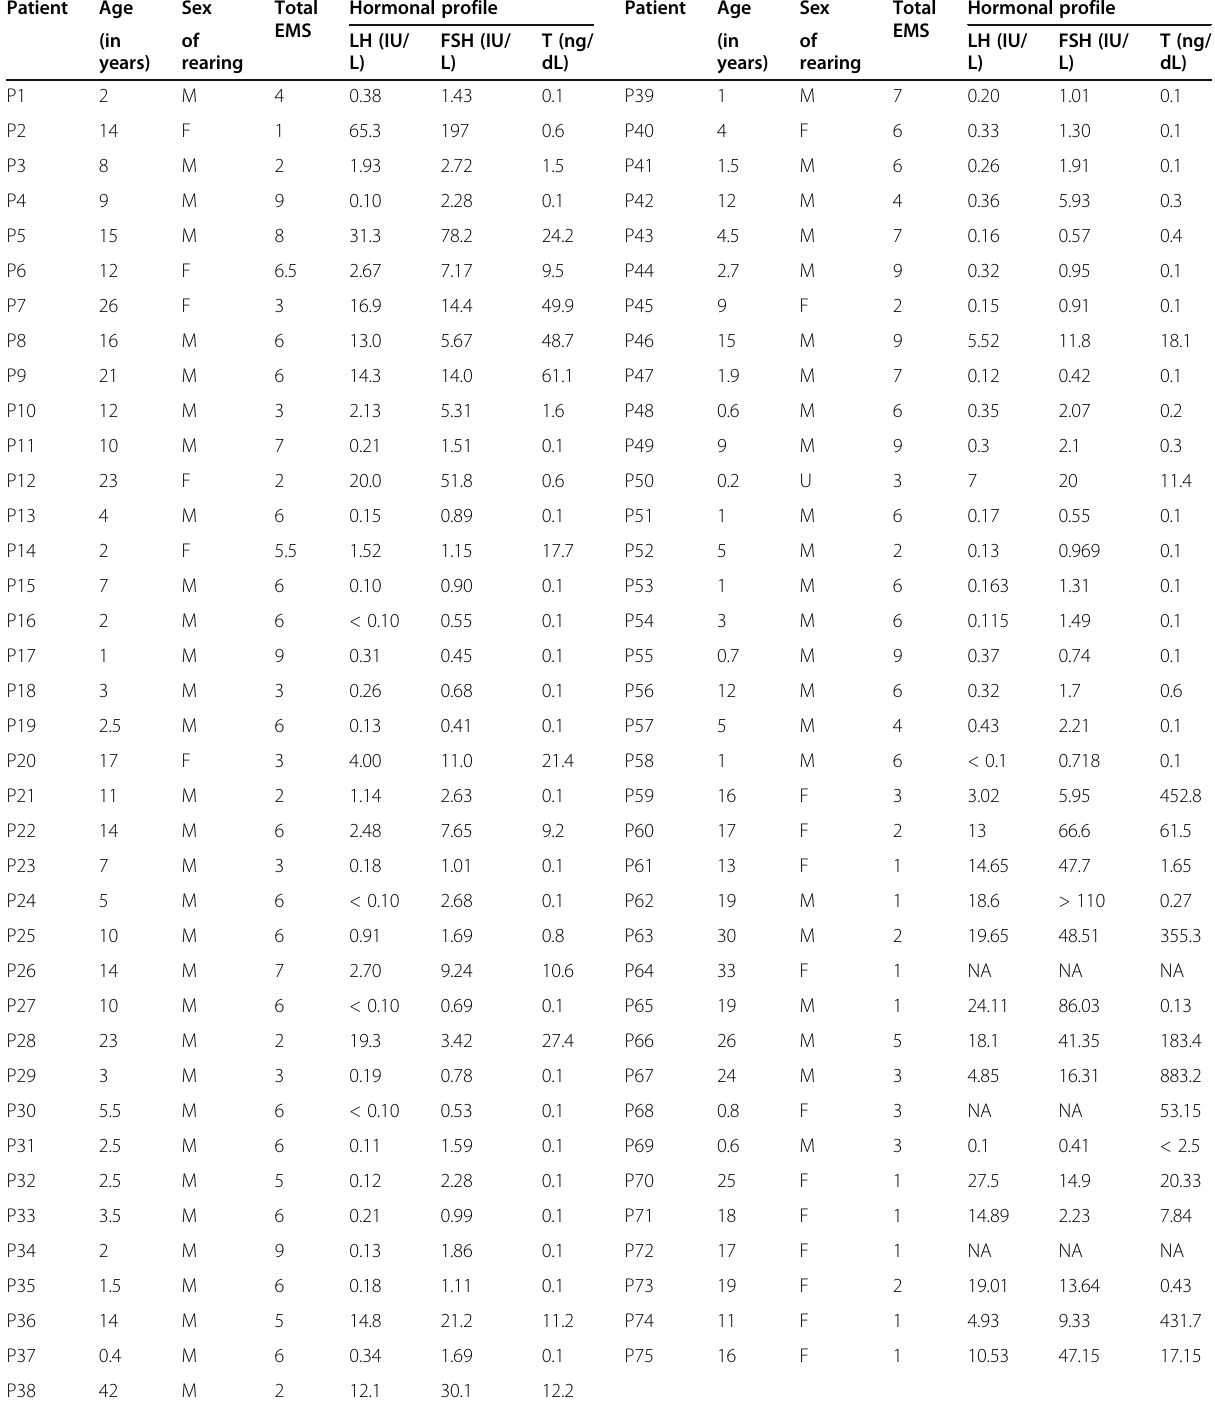
Table 1 Clinical profile of patients